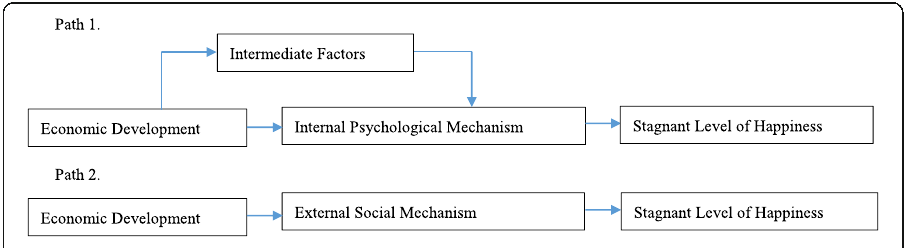
Fig. 1 Two paths to explain the Easterlin